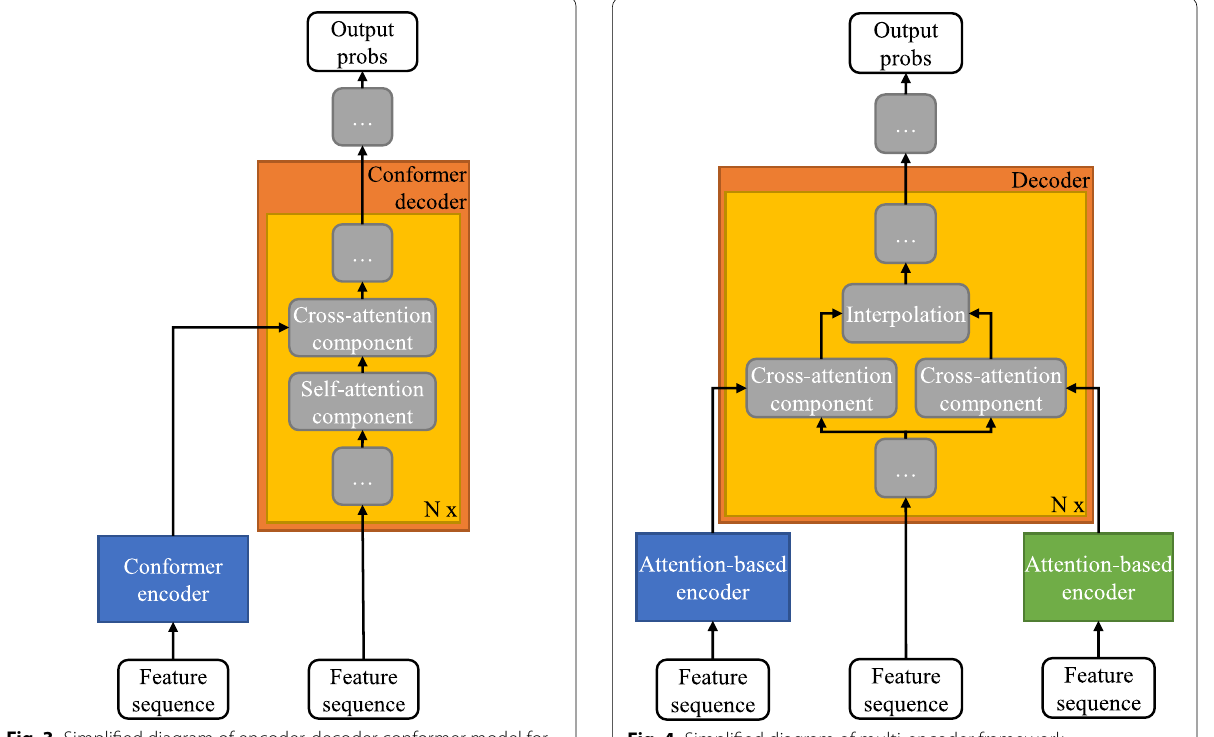
Fig. 4 Simplified diagram of multi-encoder